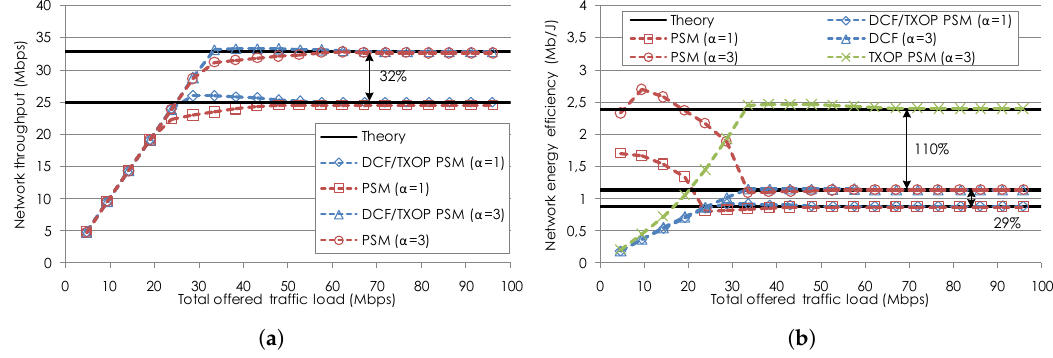
Figure 2. Network throughput and energy efficiency of the evaluated mechanisms with α = 1 and α = 3 rounds of data transmissions as a function of the traffic load. ( a ) Throughput. ( b ) Energy